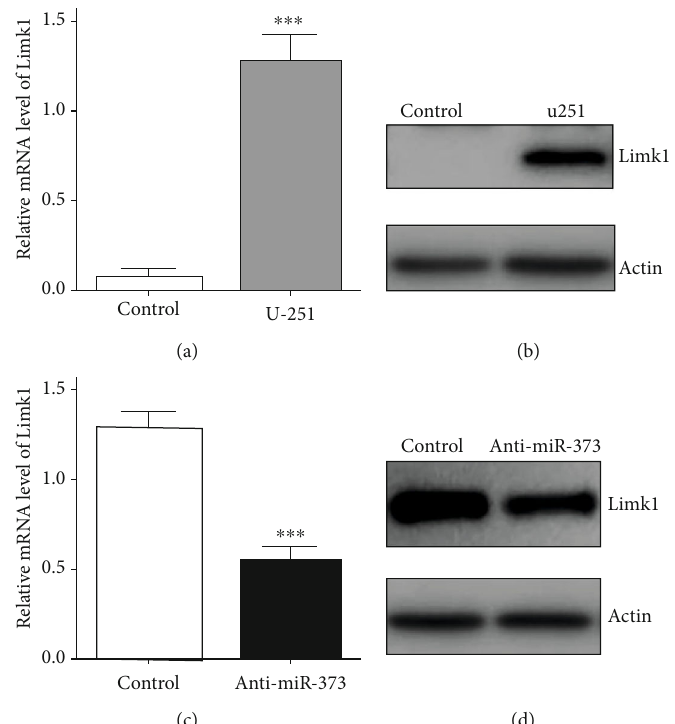
Figure 6: E ff ects of anti-miR-373 on Limk1 expression. (a) High Limk1 mRNA level was observed by the real-time quantitative PCR in U-251 cells, and (b) western blot results also proved that high Limk1 expression was obtained in U-251 cells; (c) Limk1 mRNA level was reduced by the real-time quantitative PCR in U-251 cells after anti-miR-373 transfection, and (d) lower Limk1 expression was obtained after anti-miR-373 transfection in U-251 cells (bars indicate the standard deviation of the mean; each experiment was performed in triplicate; ∗∗∗ p < 0 : 001